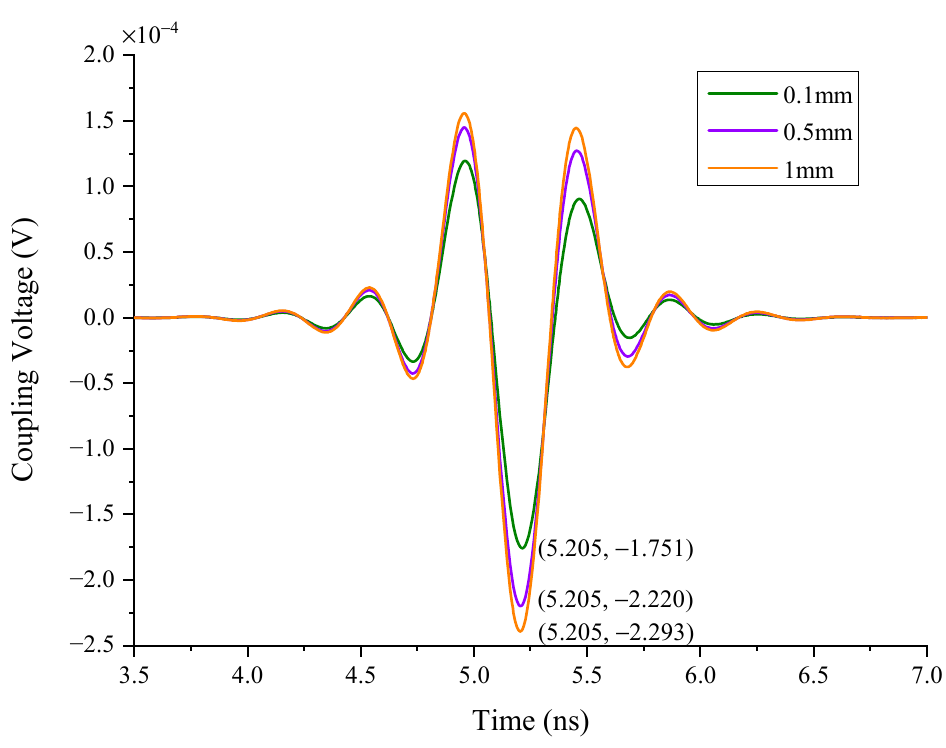
Figure 16. The responses of the different radii of a single wire.